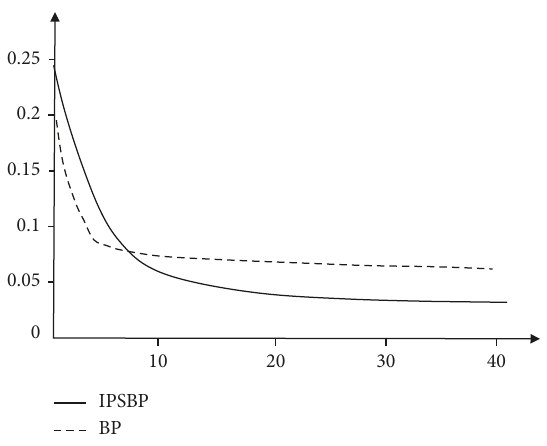
Figure 4: The variation of error with